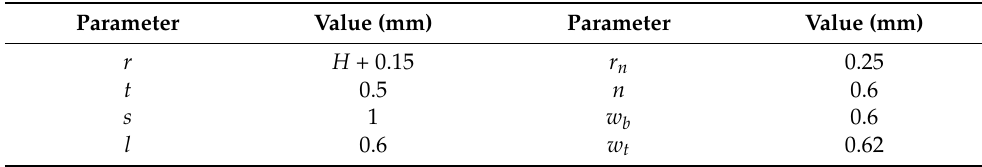
Table 3. Values of the parameters used in the design of the final unit cells with the sealing structure shown in Figure